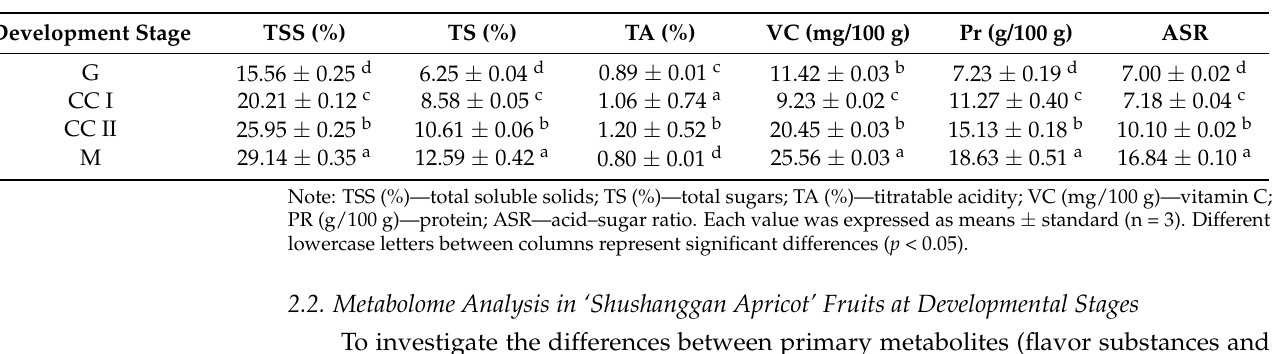
Table 1. Soluble solid content, soluble sugar, organic acid, vitamin C and protein contents in ‘Shushanggan apricot’ fruit during development and ripening.